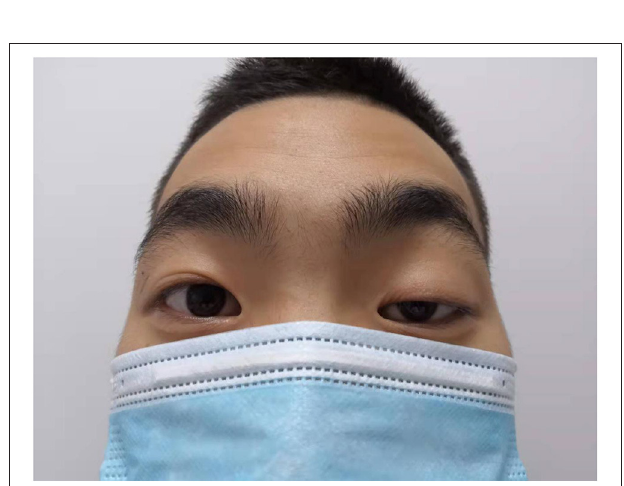
FIGURE 2 | Patient had weakness of the left eyelid